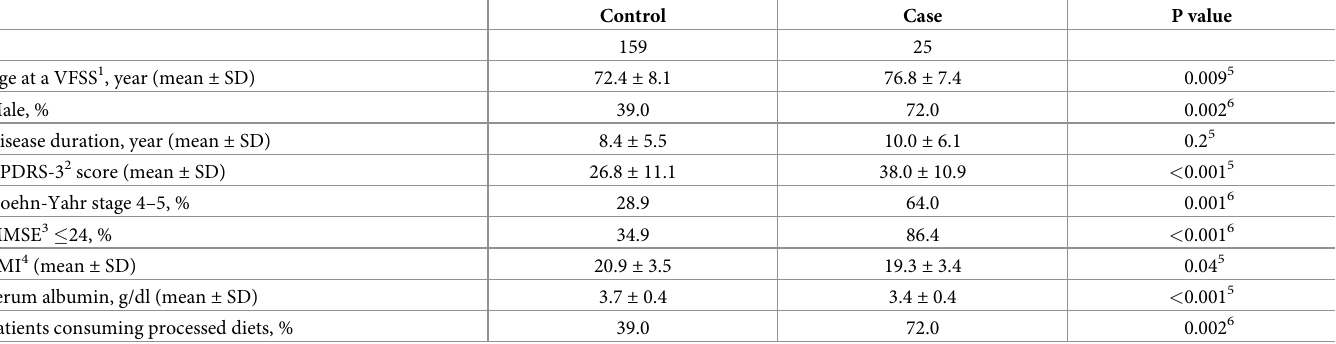
Table 1. Demographic and clinical profiles of cases and